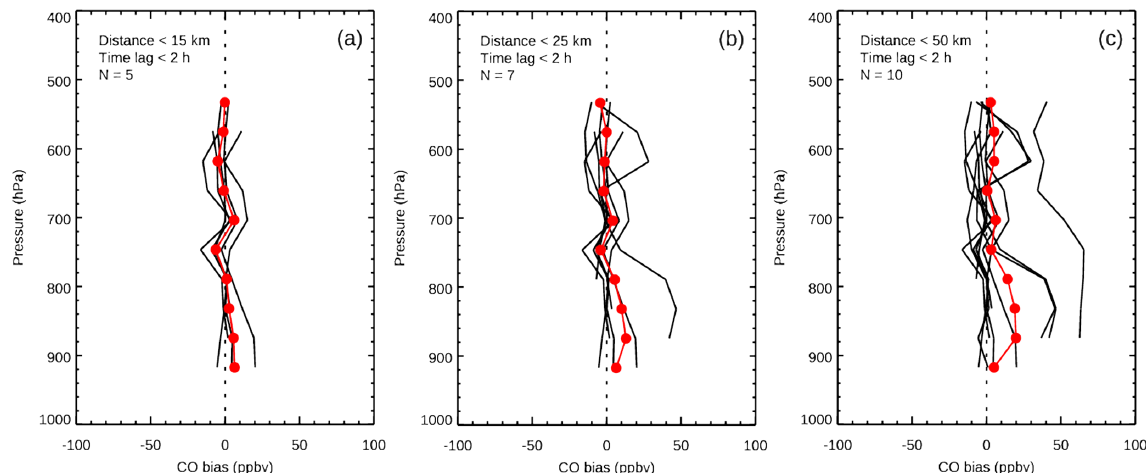
Figure 3. Differences between colocated CO vertical profiles from AirCore and NOAA aircraft flask campaign (AirCore minus aircraft data). Black lines show the bias for each colocated pair, while averaged biases from all pairs are shown in red. Colocation criteria and number of colocated pairs are indicated in each